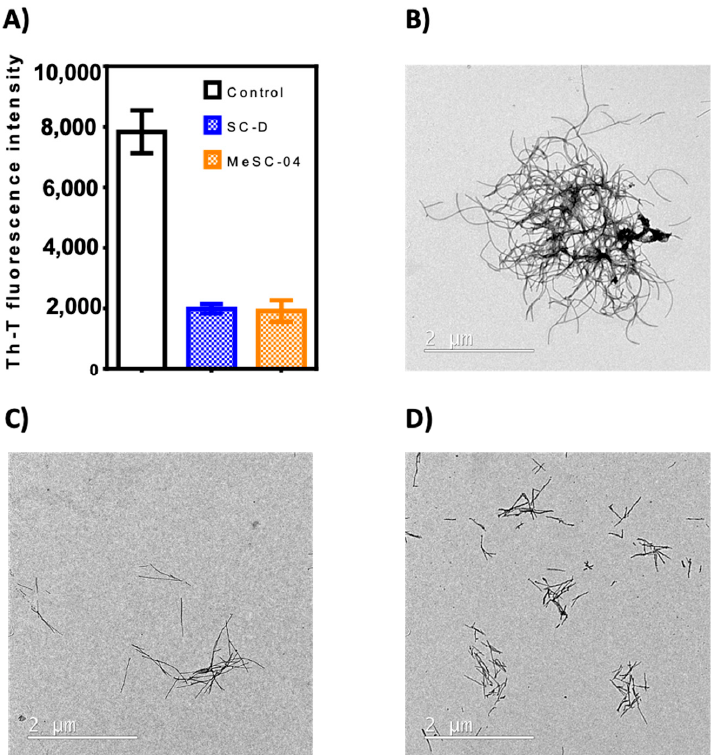
Figure 4. In vitro inhibitory characterization of compounds SC-D and MeSC-04. ( A ) End-point Th-T fluorescence signal after 48 h of aggregation of α -Syn in the absence (white) or presence of 100 µM concentrations of compounds SC-D (blue) and MeSC-04 (orange). ( B – D ) Representative transmission electron microscopy images of end-point aggregates in the absence ( B ) or presence of 100 µM concentrations of compounds SC-D ( C ) and MeSC-04 ( D ). SC-D was used as reference for the inhibition of α -Syn aggregation. Each experiment was repeated at least in triplicate. A one-way ANOVA test with Dunnett’s multiple comparison was performed to analyze the statistical significance.